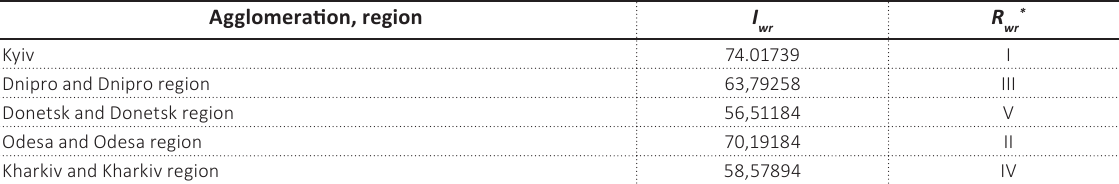
Table 4. An integral indicator of social, environmental and economic assessment of wellness and recreation and the agglomeration rating, 2018